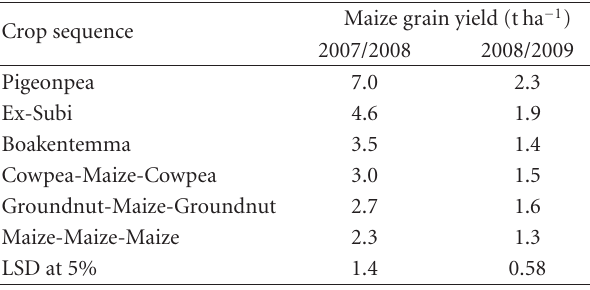
Table 3: E ff ect of crop sequence on maize grain yield at 12% mois- ture